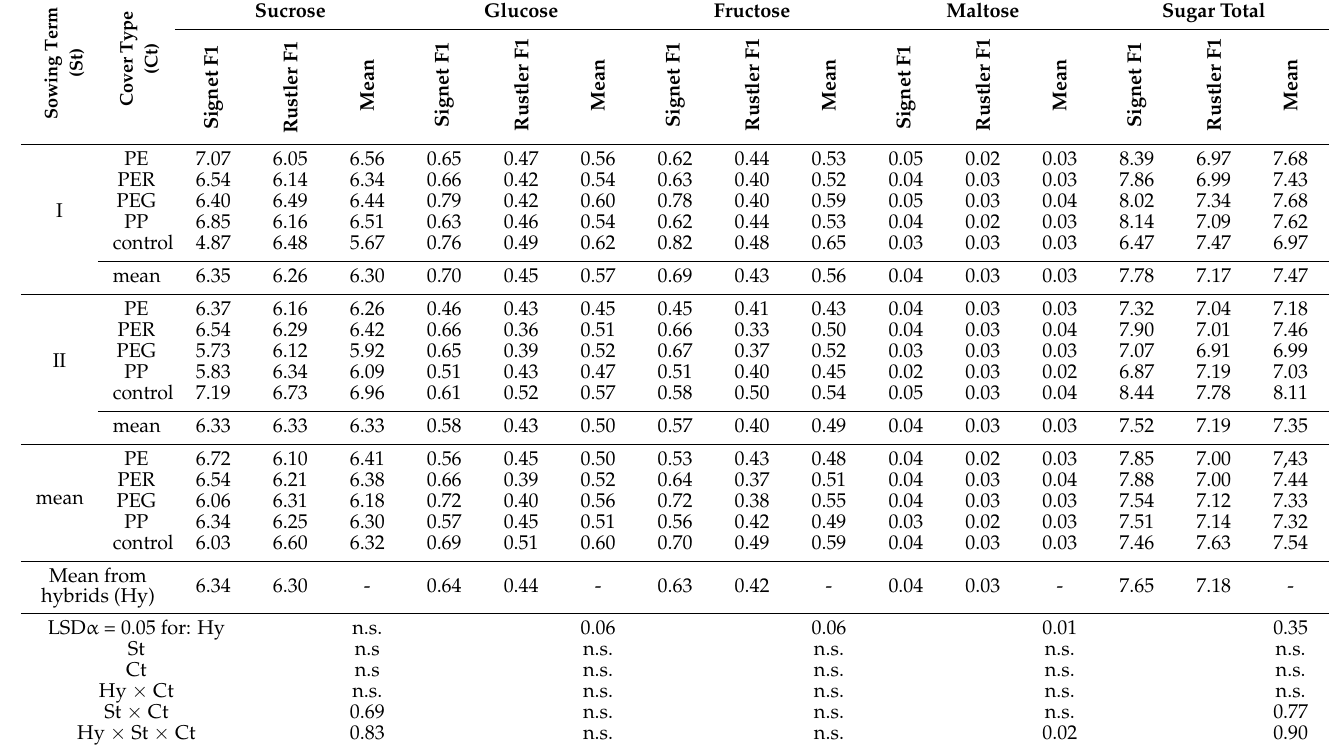
Table 4. The effect of experimental treatments on sugar content in maize grain (% of fresh grain). Average from year 2012. Table 3. Total cobs yield (dt per ha) and percentage (%) of marketable cobs yield. Average from years 2012–2014.